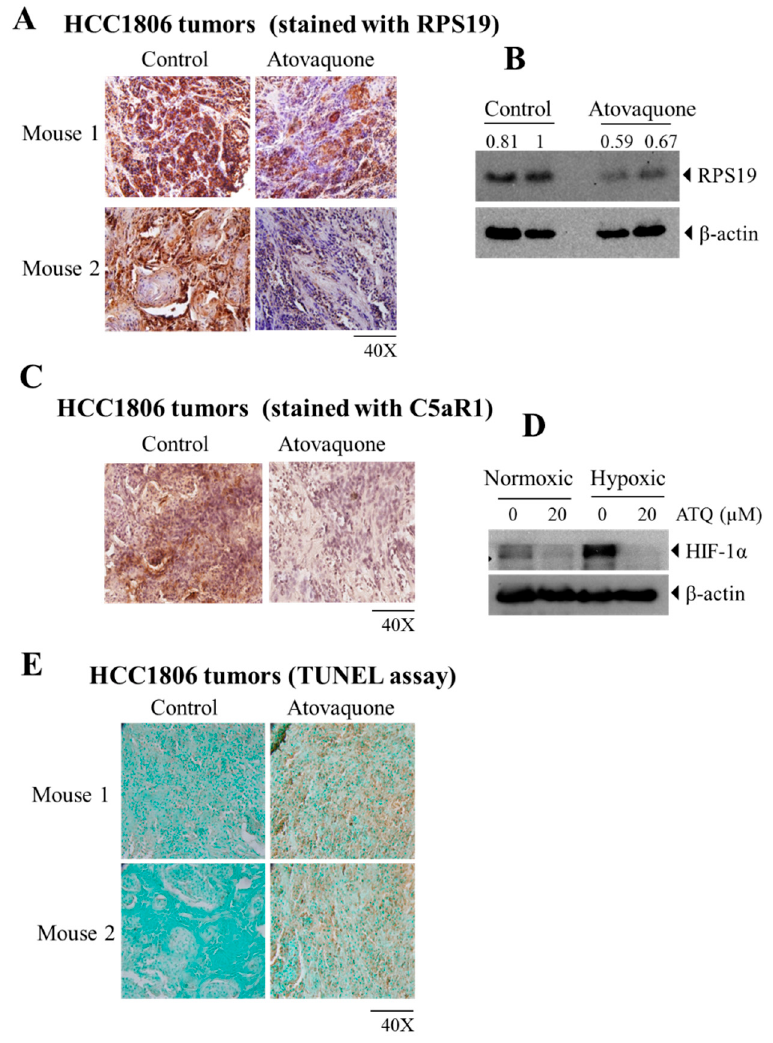
Figure 5. Reduction in the expression of RPS19 with increased apoptosis after atovaquone treatment. Tumors were isolated from mice bearing HCC1806 tumors at the day of termination. A part of tumor was fixed in formalin for immunohistochemical analysis, as well as for Western blot analysis. ( A ) Treated and untreated HCC1806 tumor sections were analyzed for RPS19 by IHC. ( B ) Western blot analyses showing the expression of RPS19 in control and treated HCC1806 tumors. ( C ) Expression of C5aR1 in atovaquone-treated and untreated HCC1806 tumors. ( D ) HIF-1 α expression in HCC1806 cells treated with or without atovaquone (ATQ) under both normoxic and hypoxic conditions by Western blotting. ( E ) Representative images of excised tumor sections from control and atovaquone-treated group analyzed by TUNEL assay. Each section indicates a tumor from an individual mouse.